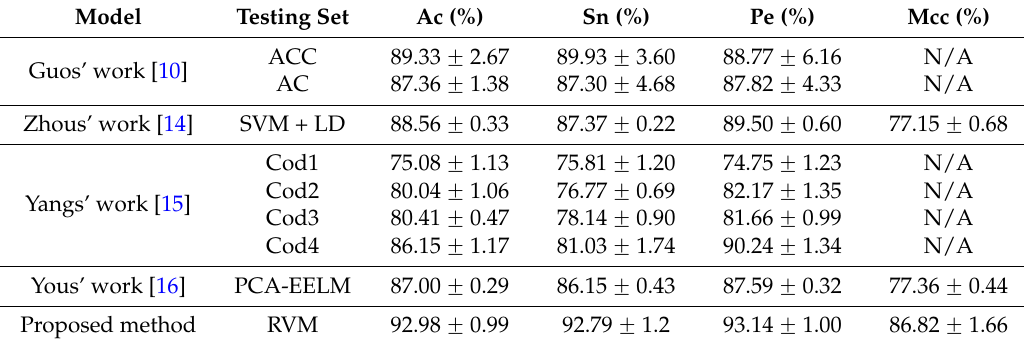
Table 5. Predicting ability of different methods on the yeast dataset. ACC: Auto Covariance; LD: Local Description; PCA: Principal Component Analysis; EELM: Ensemble Extreme Learning Machines; N/A: No Available.